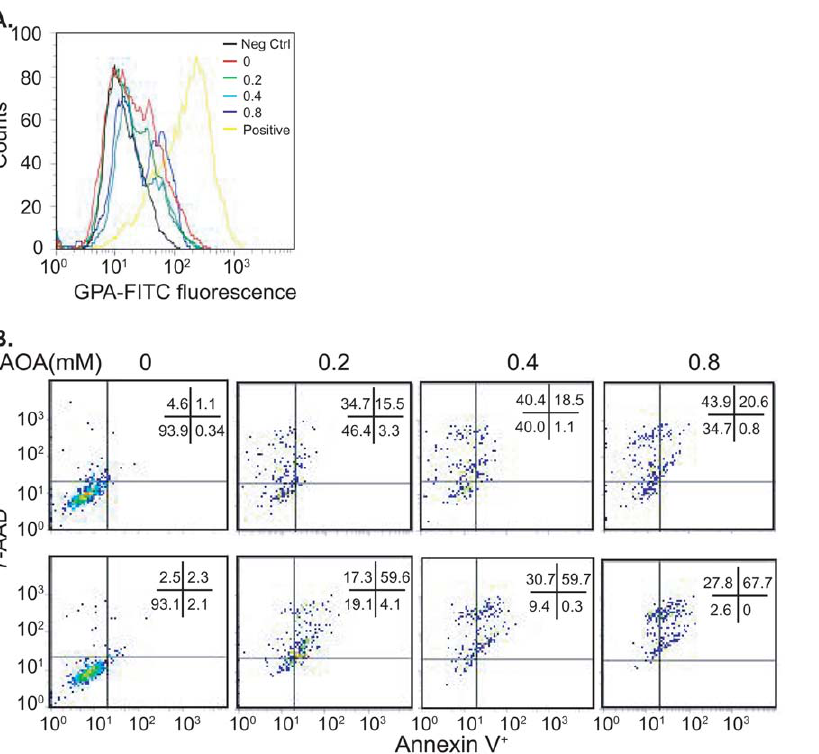
Figure 6. Supplementation by exogenous amino-oxyacetate in medium cannot induce erythroid differentiation but does induce cell death. A. Cells were treated with different concentrations of amino-oxyacetate and expression levels of the erythroid marker glycophorin A on the surface of K562 cells were assessed using a mouse FITC-conjugated anti-human glycophorin A antibody. Each histogram is representative of three experiments. B. K562 cells with or without ME2 knockdown were incubated with different concentrations of AOA for 72 h. Cell death was assessed by flow cytometry. Top: pLKO; Bottom: shME2-3. Data are representative of two independent experiments.